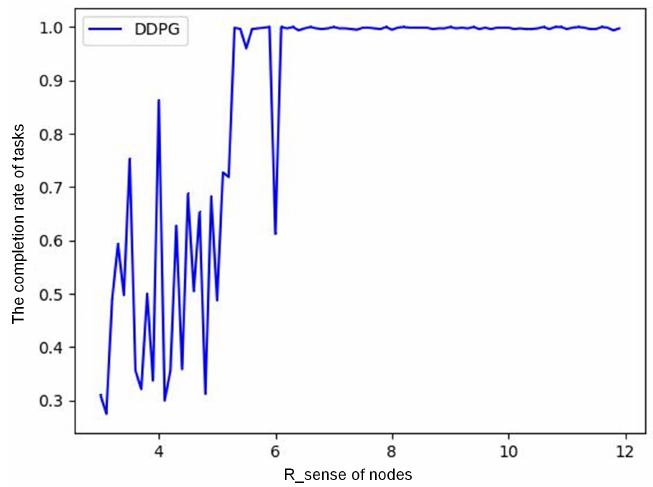
Figure 6. Relationship between sensing radius and task completion